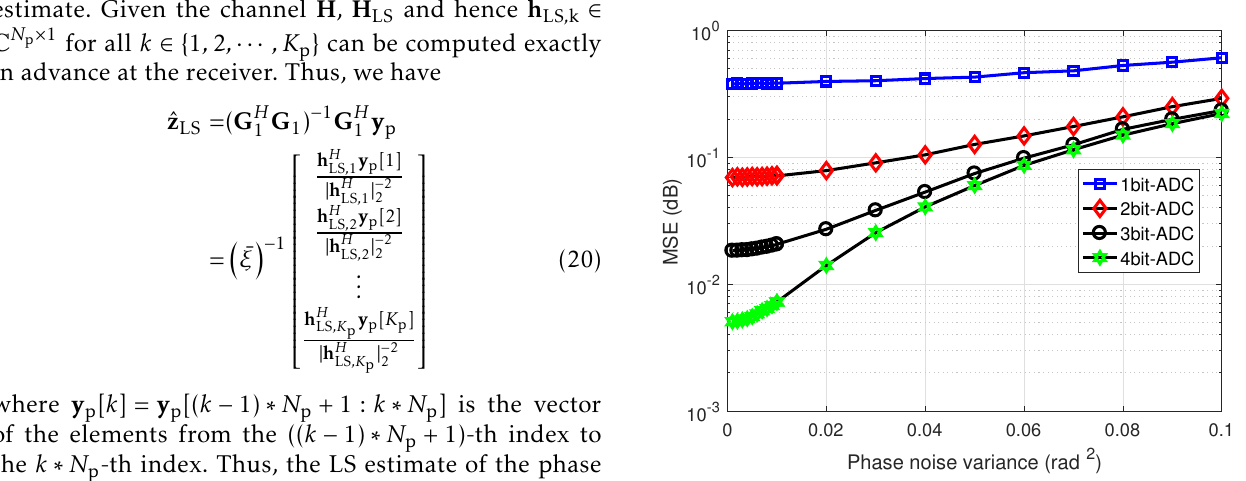
Figure 2. MSE as a function of phase noise variance, the level of CSI is